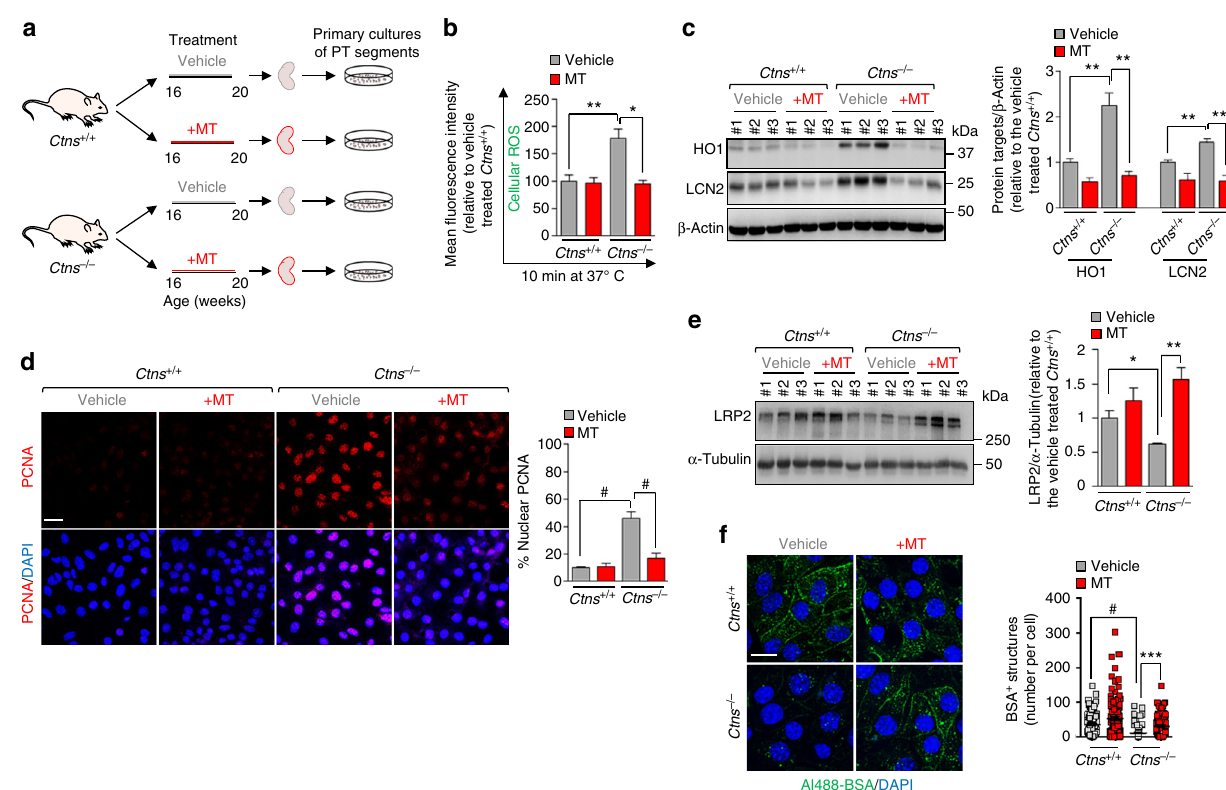
Fig. 9 Mitochondrial ROS scavenging ameliorates PT cell function in Ctns − / − mice. a Ctns mice were treated for 30 days with daily intraperitoneal injections of either saline or MT (1 mg kg − 1 body - weight, n = 4 mice for group). Following treatment, mPTCs obtained from microdissected Ctns kidneys were analysed. b The mPTCs were loaded with CellROX (5 μ M for 10 min at 37 °C) and analysed by confocal microscopy. Quanti fi cation of fl uorescence intensity was obtained from fi ve randomly selected fi elds per condition, with each containing ~ 20 – 25 cells. c Western blotting and densitometric analyses of HO1 and lipocalin-2 (LCN2) protein levels. β -Actin was used as a loading control. d The cells were immunostained for PCNA and imaged by confocal microscopy. Quanti fi cation of PCNA + nuclei (in percentage of the total nuclei) obtained from fi ve randomly selected fi elds per condition, with each containing ~ 20 – 25 cells. e Western blotting and densitometric analyses of LRP2 protein levels. α -Tubulin was used as loading control. f The cells were loaded with Al488-BSA (50 μ g ml − 1 for 15 min at 37 °C), fi xed, and analyzed by confocal microscopy. Quanti fi cation of numbers of Al488-BSA + structures ( n = 100 cells pooled from three mouse kidneys per condition; each point representing the number of BSA + structures in a cell). Nuclei counterstained with DAPI (blue) in d and f . Plotted data show mean ± SEM. One-way ANOVA followed by Bonferroni ’ s post hoc test, * P < 0.05, ** P < 0.01, *** P < 0.001, and # P < 0.0001 relative to mPTCs from vehicle-treated Ctns + / + or Ctns − / − mice. Scale bars are 10 μ The link between defective autophagy, compromised mito- phosphorylation of the zona occludens-1 (ZO-1) adaptor protein, chondria, and oxidative stress was substantiated by the increased disrupting the integrity of the tight junction complex 29 . As ZO-1 phosphorylation rate of ZO-1 induced by the shRNA-mediated traps the Y-box transcription factor ZONAB that is known to knockdown of Atg 7 in mPTCs (Supplementary Fig. 8a) or by the treatment of the cells with autophagy inhibitors (SAR-405 and Spautin-1; Supplementary Fig. 8b), with H 2 O 2 (Supplementary Fig. 8c) or with the mitochondrial complex I inhibitor Rotenone (ROT)-stimulating mitochondrial ROS (Supplementary Fig. 8d,e). Treatment with ROT induced ZONAB translocation and signaling (Supplementary Fig. 8f, g), re fl ected by increased proliferation (Supplementary Fig. 8h) and decreased endocytic uptake (Supplementary Fig. 8i). The relevance of the abnormal tight junction signaling in cystinosis was con fi rmed by gain- and loss-of-function experi- ments in mPTCs. shRNA-mediated knockdown of Csda encoding ZONAB (Fig. 7g – i and Supplementary Fig. 9a – c) or over- expression of exogenous TJP1 encoding ZO-1 (Supplementary Fig. 9d, e), which functionally inhibits ZONAB 27,28 , signi fi cantly decreased the proliferation markers and rescued the endocytic uptake in Ctns − / − cells. Conversely, depletion of ZO-1 (shRNA- mediated knockdown of Tjp1 ; Supplementary Fig. 10a – c) or overexpression of Csda (Supplementary Fig. 10d) triggered the activation of ZONAB signaling (Supplementary Fig. 10e) with